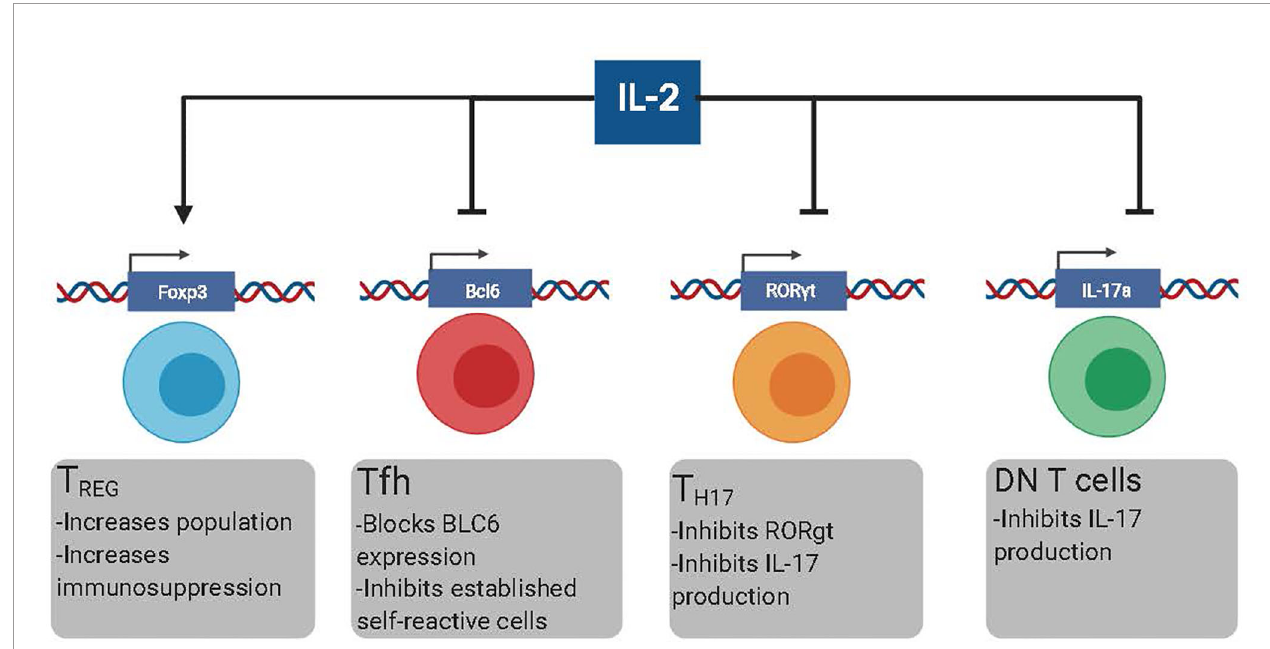
FIGURE 1 | The different effects of low dose rIL-2 therapy in autoimmunity. Low dose rIL-2 stabilizes FoxP3 program in Treg cells which increases both the size of the population and enhances immunosuppression. Low dose rIL-2 therapy can both inhibit the generation of new self-reactive Tfh cells and decrease already present self-reactive Tfh cells by blocking Bcl6. IL-6 blockade will make Tfh cells more suspectable to IL-2 signaling. Low dose rIL-2 can inhibit Th17 cells by diminishing expression of RORgt and inhibiting IL17a expression. Low dose rIL2 can also inhibit IL-17 production by DN T cells by directly inhibiting IL17a